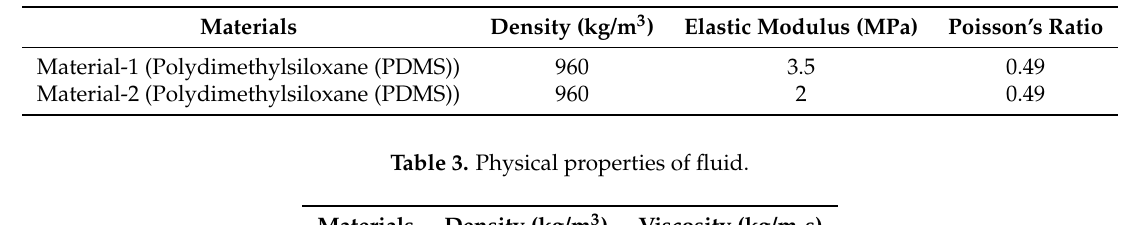
Table 2. Physical properties of solid.